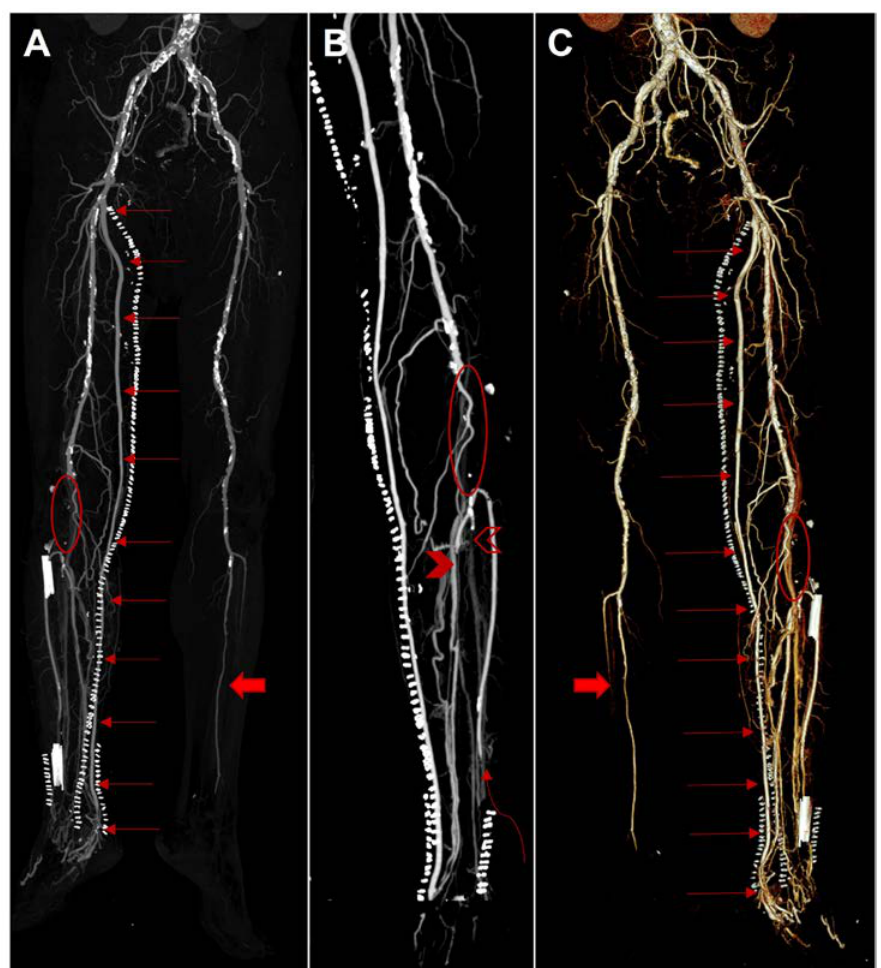
Figure 1. Three-dimensional reconstruction computed tomography angiography (Siemens Somatom Definition AS, Siemens Healthcare, Erlangen, Germany) after open deep vein arterialization; all images show diffuse calcified atherosclerosis and a greater enhancement of the vessels of the right leg compared to the left side in relation to the presence of arteriovenous bypass resulting in early opacification and ectasia of the superficial and deep venous vessels. ( A ), anterior view of maximum intensity projection (MIP) shows patency of the right saphenous graft from the superficial femoral artery to the posterior tibial vein (red arrows). Note occlusion of the right popliteal artery (red ellipse) and left leg arteries apart from the left peroneal artery (full red arrow). ( B ), posterior view of MIP on right leg shows occlusion of the popliteal artery (red ellipse), segmental occlusion of the anterior tibial artery in the distal tract (curved red arrow), occlusion of the peroneal artery (empty red arrowhead), and segmental occlusion of the posterior tibial artery in the middle tract with distal patency (full red arrowhead). ( C ), posterior view of Volume Rendering Technique shows patency of the saphenous graft from the superficial femoral artery to the posterior tibial vein (red arrows). Note occlusion of the right popliteal artery (red ellipse) and left leg arteries apart from the left peroneal artery (full red arrow).